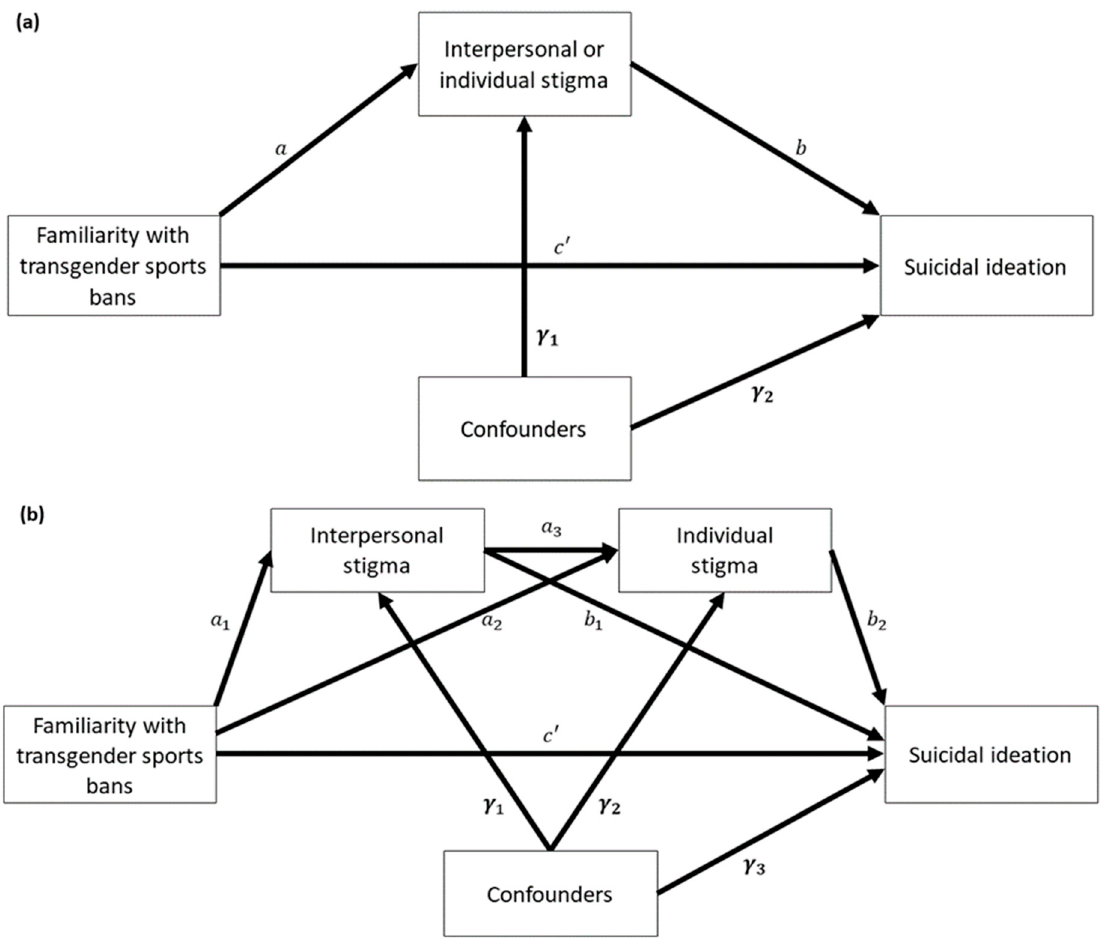
Figure 1. Conceptual diagrams of the ( a ) univariate mediator model and ( b ) serial mediator model.